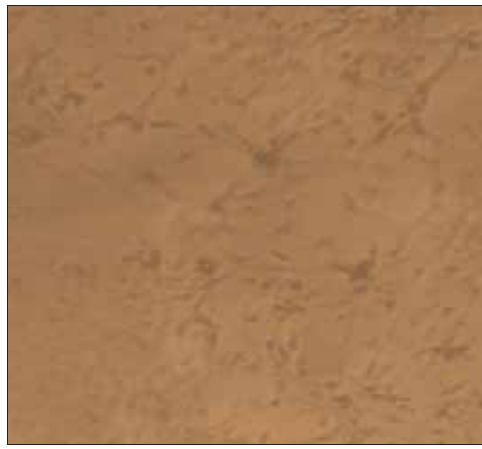
Figure-7: Cytopathic effect produced by vaccine strain of fowl pox virus after 96 h of PI